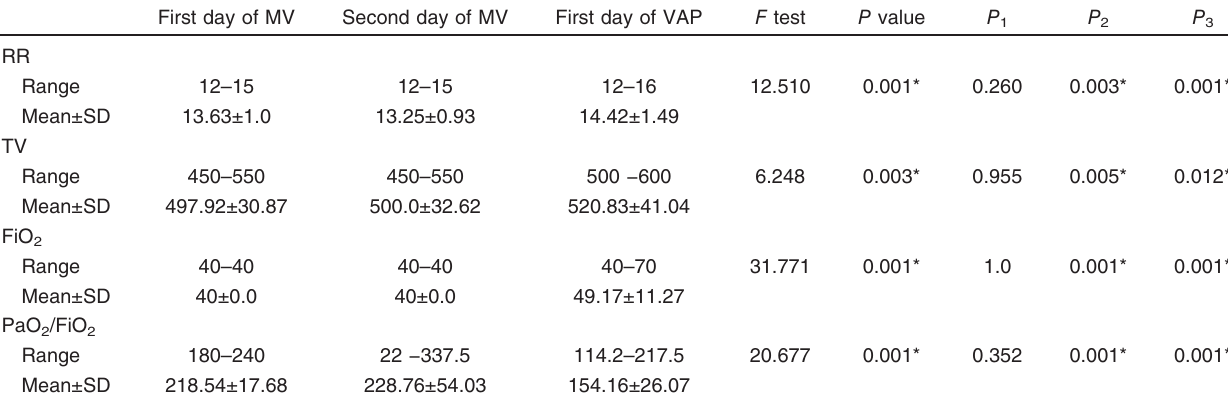
Table 7 Some ventilator parameters on the first day and the second day of mechanical ventilation, and on the first day of ventilator-associated pneumonia